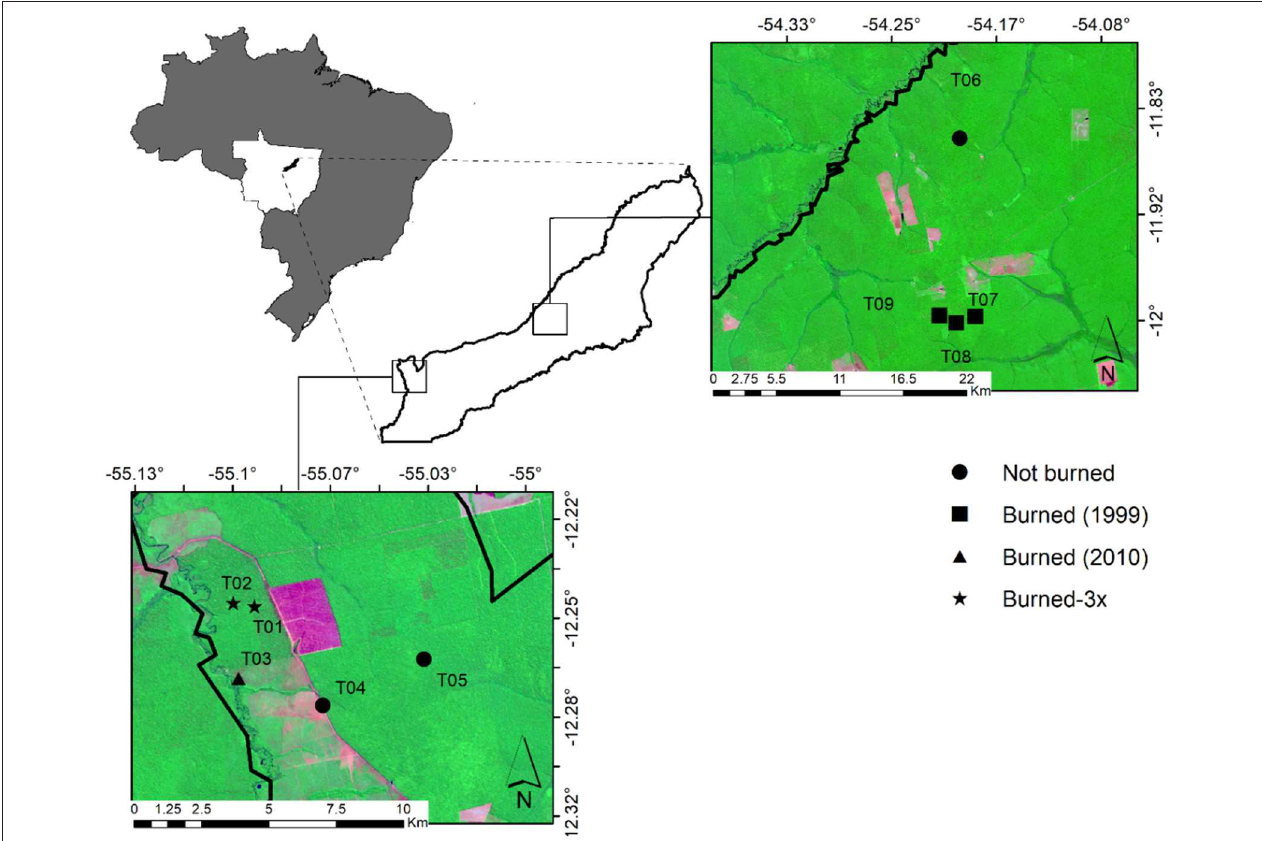
FIGURE 1 | Study sites in southern Amazonia in Mato Grosso State, in the municipality of Feliz Natal, showing the distribution of nine study sites, with four plots per site. Sites were classified as “not-burned (T04, T05, and T06)”, “burned-1999 (T07, T08, and T09)”, “burned only once, in 2010 (T03),” and “Burned-3x (burned three times in 2006, 2010, and 2013) (T01 and T02)”.